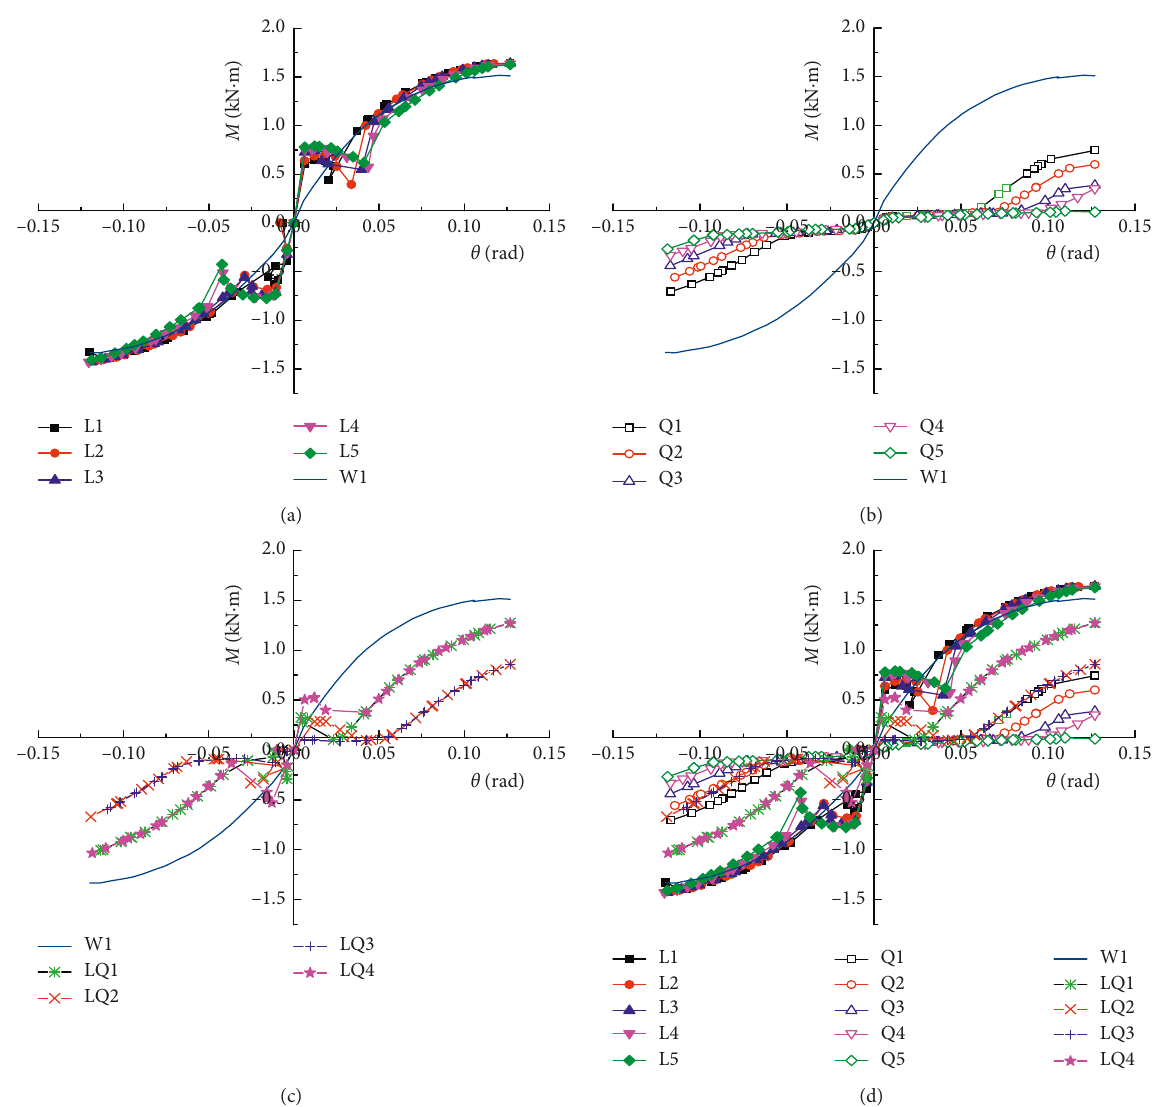
Figure 15: Bending moment-angle (M- θ ) skeleton curves. (a) Pulling damaged and intact frame skeleton curves, (b) contraction damaged and intact frame skeleton curves, (c) mixed damaged and intact frame skeleton curves, and (d) all frame skeleton